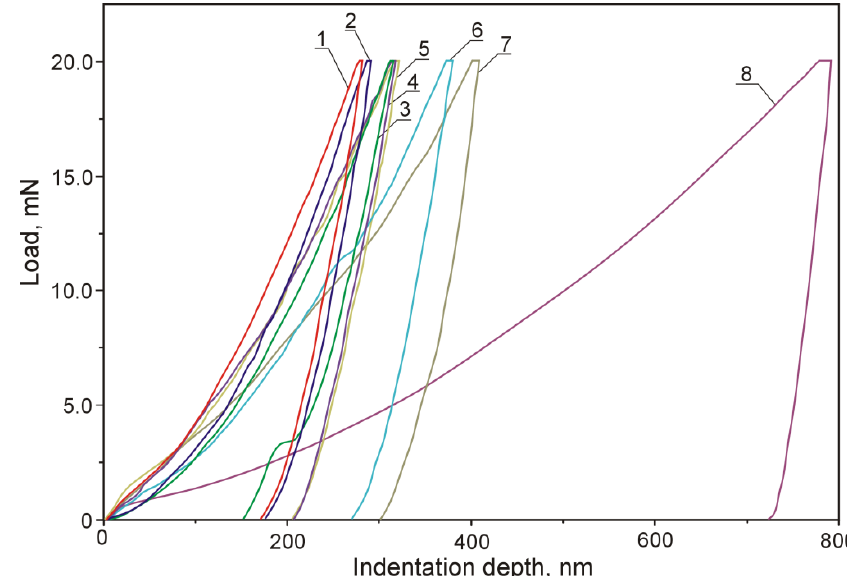
Figure 14. Plots representing indenter face displacement in the course of loading and unloading in the course of indentation tests of: (1)—Al(Fe,Mn, M )Si; (2)—Al(Cr,V, M )Si; (3)—Si crystals; (4)—Al 4.5 FeSi; (5)—AlFeNi M (6)—Al 7 Cu 4 Ni; (7)—Al 2 Cu; and (8)—the matrix.